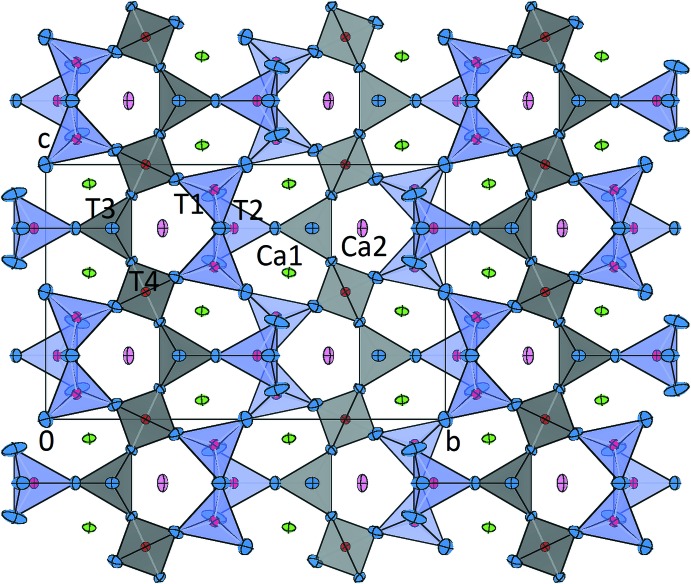
Projection of the crystal structure of Ca3CoAl4O10 in a view parallel to [100]. Displacement ellipsoids are shown at the 90% probability level. Colour codings for the atoms and polyhedra are as follows: blue: oxygen; red: aluminium/cobalt; Ca1: pink; Ca2: green; cobalt-containing tetra­hedra ([T1O4] and [T2O4]): lilac; pure aluminium tetra­hedra ([T3O4] and [T4O4]): grey.